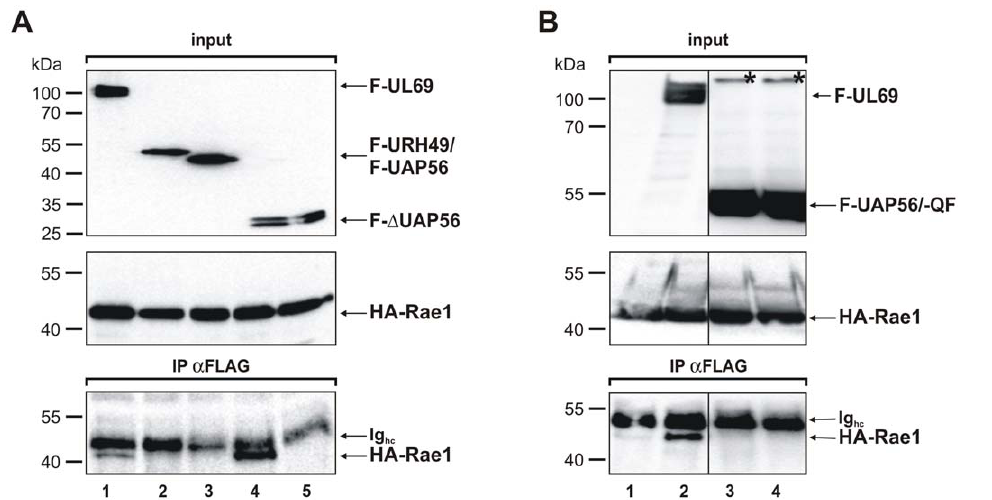
Figure 8. Interaction of Rae 1 with pUL69 and UAP56. (A + B) Coimmunoprecipitation analyses of Rae1 with pUL69 and UAP56/URH49: HEK293T cells were transfected with a vector coding for HA-Rae1 (A, lanes 1-5; B, lanes 1-9) together with FLAG-UL69 (A, lane 1), -URH49 (A, lane 2), -UAP56 (A, lane 3), -UAP56aa1-194 (A, lane 4) or -UAP56aa195-428 (A, lane 5). Alternatively, HA-Rae1 was cotranfected with an empty vector (B, lane 1), FLAG- UL69 (B, lane 2), FLAG-UAP56 wildtype (B, lane 3) or FLAG-UAP56 Q289R + F312A (B, lane 4). Two days posttransfection the amount of protein in the input was analyzed by Western blotting (input, A, lanes 1–5; B, lanes 1–4). Immunoprecipitation was performed using an anti-FLAG antibody and coimmunoprecipitated proteins were visualized by Western blotting using polyclonal HA-antibody (IP a FLAG, A, lanes 1–5; B, lanes 1–4). Asterisks indicate putative dimeric forms of UAP56 and UAP56 Q289R + F312A (B, lanes 3 and 4).